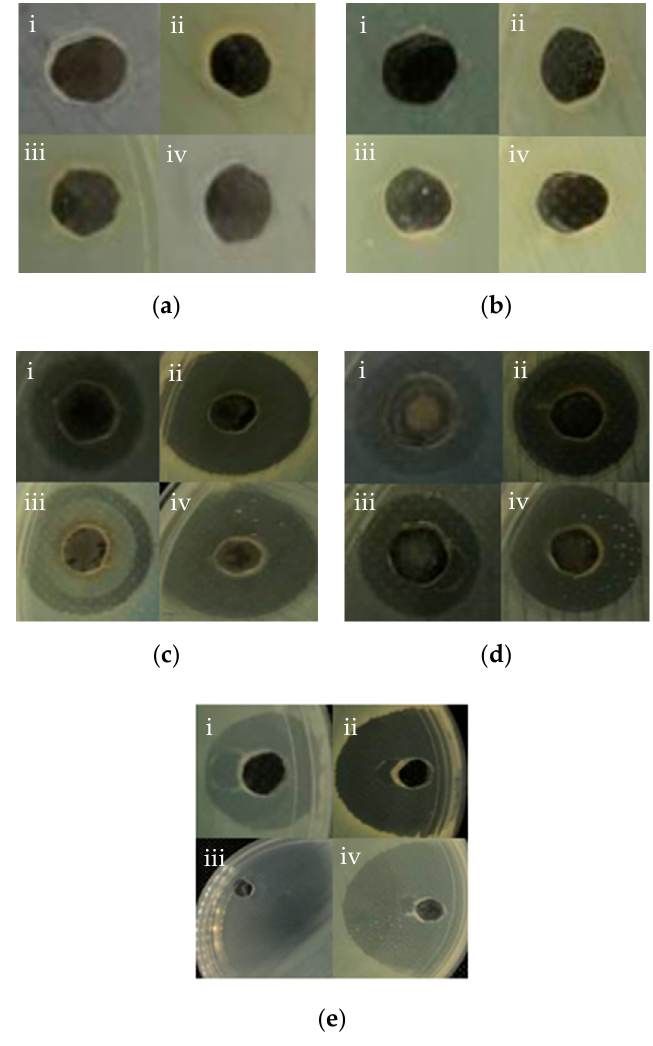
Figure 7. Inhibition zones of 100 µL of different AgNPs samples; ( a ) uncoated AgNPs from chemical synthesis, ( b ) AgNPs from chemical synthesis, with PEG-coating, ( c ) uncoated AgNPs from biological synthesis, ( d ) AgNPs from biological synthesis, with PEG-coating, and ( e ) Ampicillin (control) against pathogenic bacterial strains (i) Escherichia coli , (ii) Staphylococcus aureus , (iii) Salmonella sp., and (iv) Staphylococcus epidermidis .